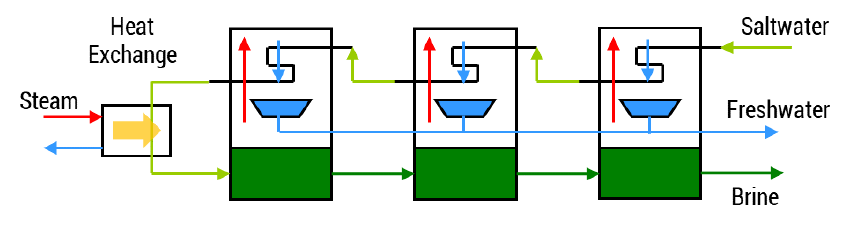
Figure 3. Multi-stage flash (MSF).